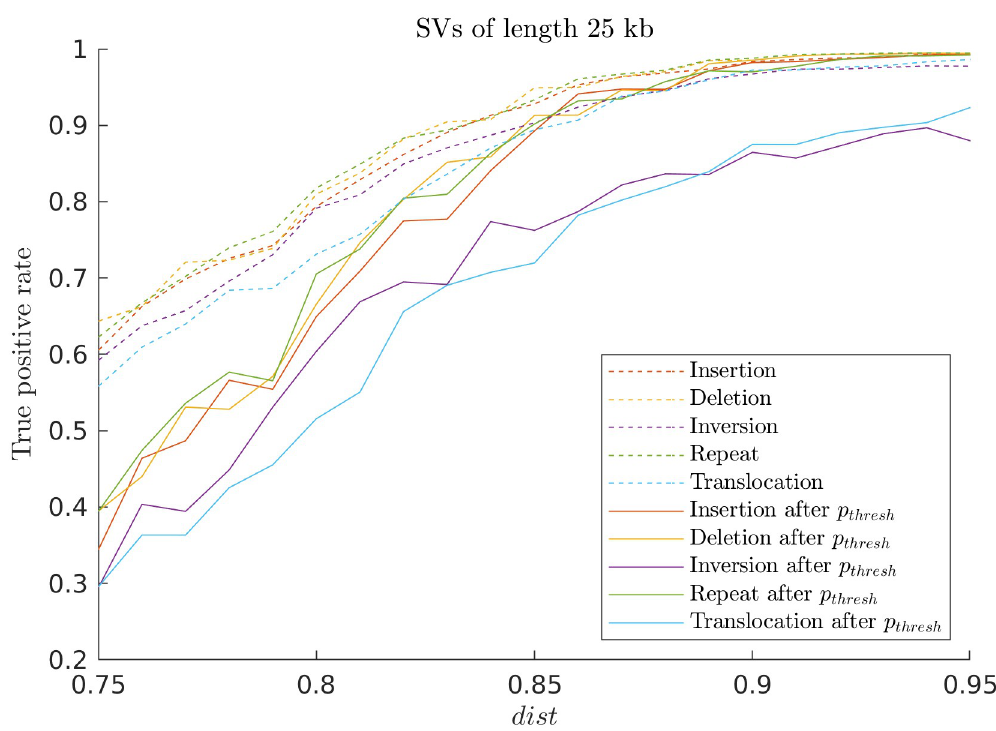
Fig 4. Dependence of true positive rate on noise in noisified random SV barcodes of different SVs. We evaluate the five different SVs (insertion, deletion, inversion, repeat, and translocation) with random query and reference barcodes to test how true positive rate depends on the presence of different levels of noise. The associated figure showing the TPR as a function of the lengths of the SVs is found in S7 Fig in S1 Text. We find that the success rate (here measured by a true positive rate) is close to 0 after the p-value threshold for smaller values of dist (the noise is quantified by the dist value between noisified random SV barcode and random SV bacode without noise), but gets closer to 1 for larger values of dist . We used 100 pairs of random query (250 kb) and noisified random SV data barcodes with SVs of length 25 kb for dist ranging from 0.75 to 0.95.